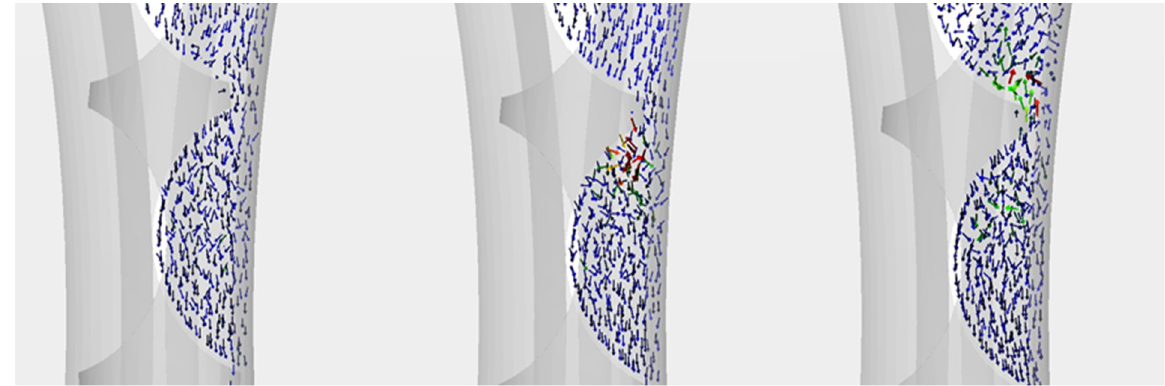
Figure 10. Distribution of material movement at the final stage of briquette